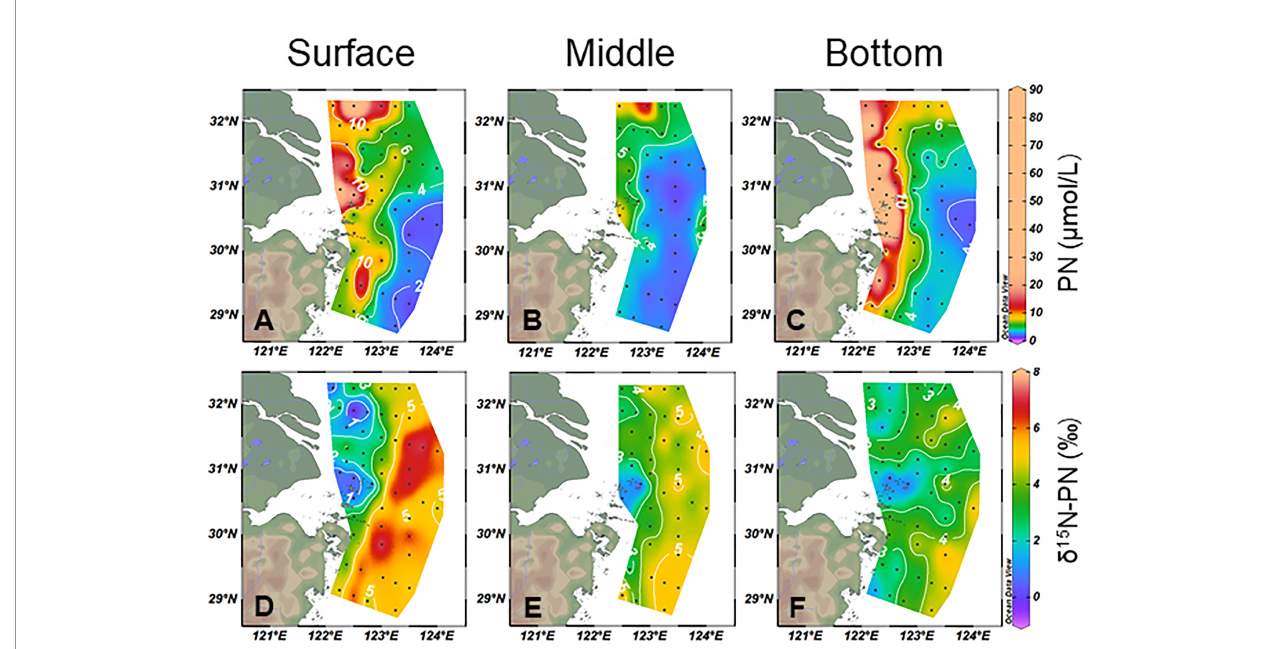
FIGURE 5 | Horizontal particulate nitrogen (PN) (A – C) and d 15 N – PN (D – F) distributions from the surface, middle, and bottom water in the study